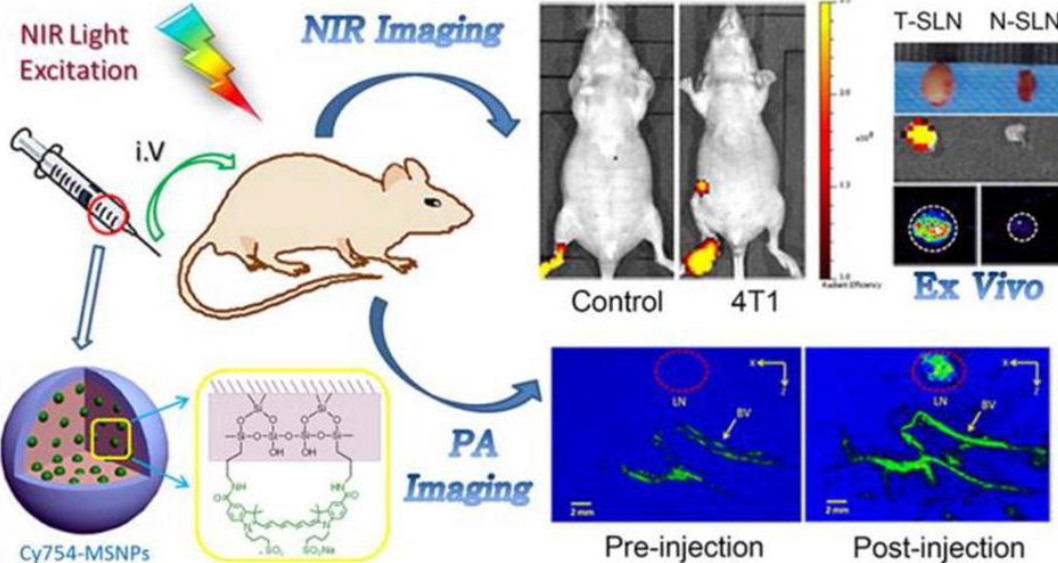
Figure 6. Schematic illustration of dye-loaded mesoporous SiNPs for both NIR fluorescent and photoacoustic (PA) imaging. Reproduced with permission from [72]. Copyright 2015 American Chemical Society.